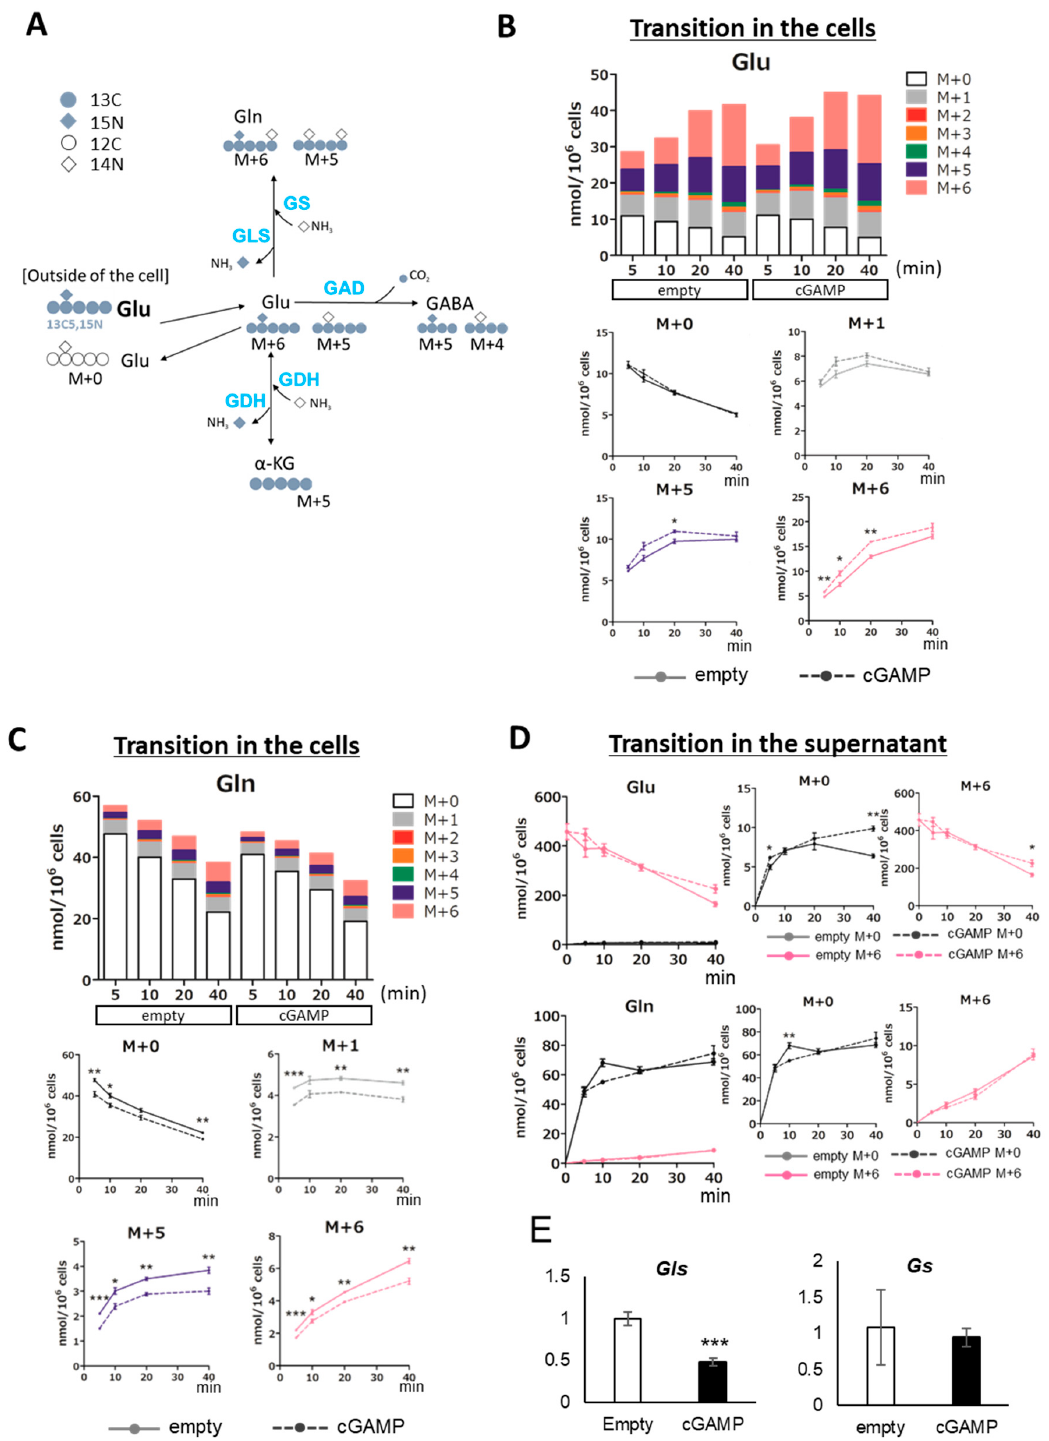
Figure 4. Evaluation of Glu and Gln metabolism in astrocytes incorporating cGAMP using 13 C5, 15 N ‐ Glu. ( A ) Predicted distribution of 13 C and 15 N taken up as 13 C5, 15 N ‐ Glu. For 13 C or 15 N ‐ labeled compounds, a representation is shown of the labeled compounds that are theoretically estimated to be the most abundant when the metabolic cycle makes one turn. ( B , C ) Transition in the amount of Glu ( B ) and Gln ( C ) in cGAMP ‐ incorporated astrocytes up to 40 min after 1 13 C5, 15 N ‐ Glu addition. ( D ) Transition in the amount of Glu and Gln in the supernatant of cGAMP ‐ incorporated astrocytes up to 40 min after 13 C5, 15 N ‐ Glu addition. ( B – D ) * p < 0.05, ** p < 0.01, *** p < 0.001, empty vs. cGAMP at each time point (n = 3, Student’s t ‐ test). ( E ) Expression of Gls and Gs mRNAs was assessed by qPCR. ***; p < 0.001, Student’s t ‐ test (n = 3).